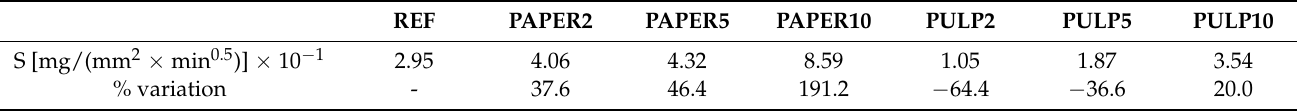
Table 4. Capillarity water absorption coefficient values and percentage